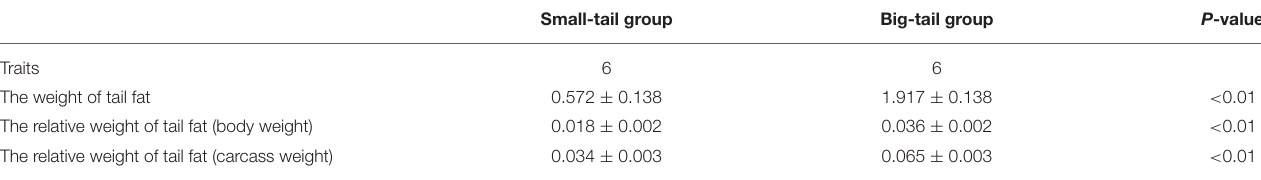
TABLE 3 | Performance of the sheep used in qRT-PCR.